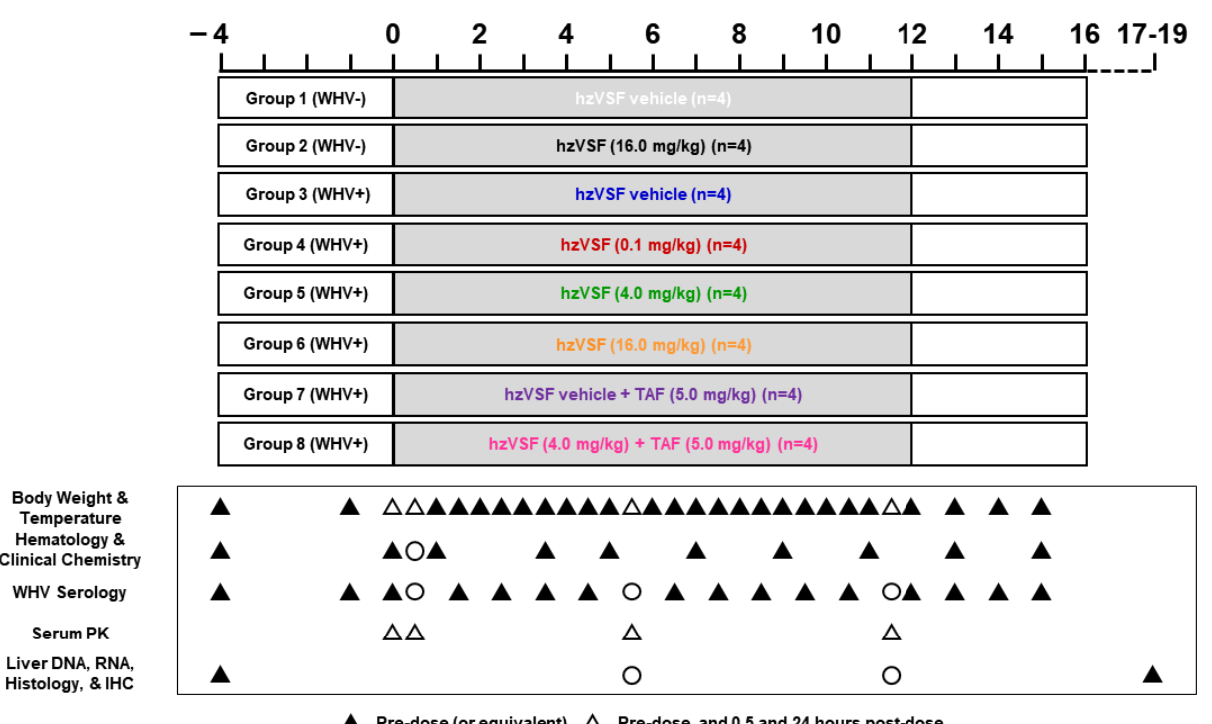
Figure 1. Design of the three hzVSF treatment studies in woodchucks. In the first study, WHV-uninfected woodchucks received iv hzVSF vehicle (Group 1) or hzVSF at a dose of 16.0 mg/kg (Group 2) twice-weekly for 12 weeks. In the second study, chronic WHV carrier woodchucks were administered iv hzVSF vehicle (Group 3) or hzVSF at doses of 0.1 mg/kg (Group 4), 4.0 mg/kg (Group 5), or 16.0 mg/kg (Group 6), respectively, twice-weekly for 12 weeks. In the third study, chronic WHV carrier woodchucks received iv hzVSF vehicle (Group 7) or hzVSF at a dose of 4.0 mg/kg (Group 8) twice-weekly for 12 weeks, together with po TAF at a dose of 5.0 mg/kg once-daily for 12 weeks. After treatment cessation, animals were followed for additional 4 weeks until the EOS in week 16. The terminal collection of liver and other organs was performed at euthanasia during weeks 17 – 19. Arrows indicate the time of measurements for the specific parameters listed. Abbreviation: IHC, immunohistochemistry.